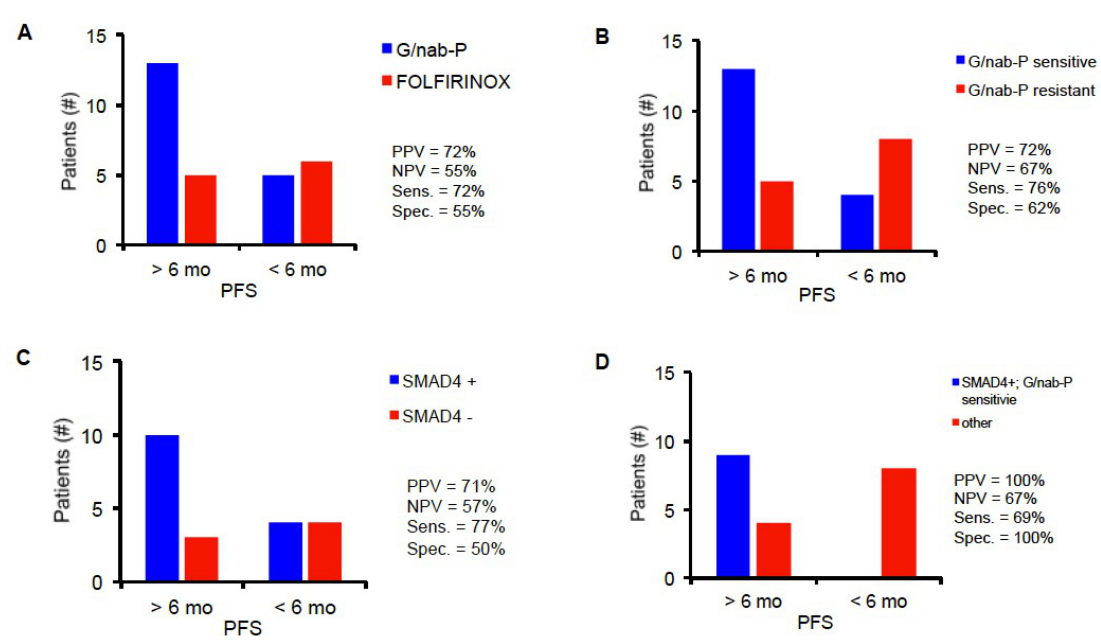
Figure 2. Performance of PGx profiling ( A ), G/nab-P sensitivity ( B ), ΔSMAD4 ( C ), and a combined analysis ( D ) to predict treatment response. Six-month PFS was used as a cut-off for predicting sensitivity and response (>6 months) or resistance and lack of response (<6 months).